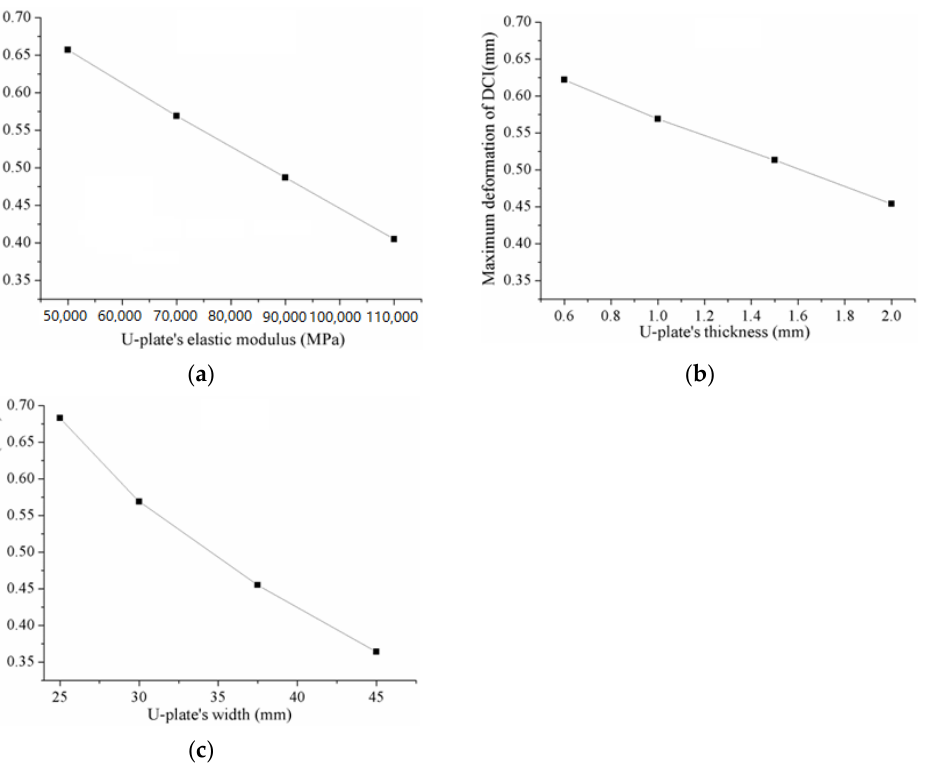
Figure 3. Influence of the U-plate’s elastic modulus and size on the DCI’s maximum deformation: ( a ) U-plate thickness and width were fixed at 1 mm and 30 mm; ( b ) elastic modulus and width at 70,000 MPa and 30 mm; ( c ) elastic modulus and thickness at 70,000 MPa and 1 mm.